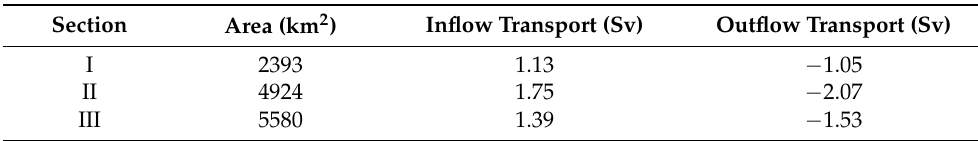
Table 1. Numerical values of the area and inflowing and outflowing transport in the depth sections between the Midriff Islands.